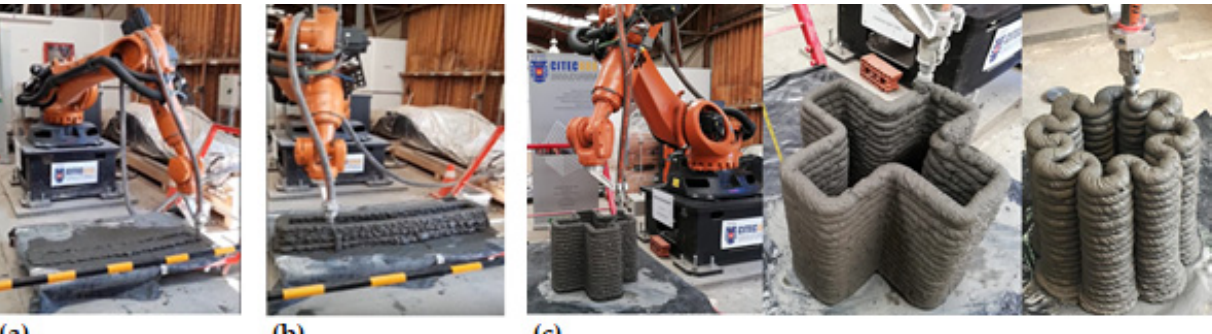
Figure 8. ( a ) Start of the printed sample, ( b ) succession of layers of the printed sample, and ( c ) other 3D concrete printed elements that were tested.